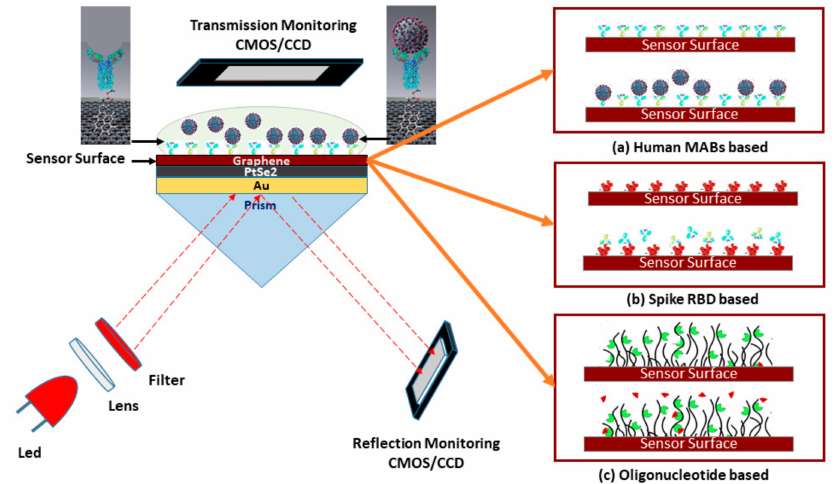
Figure 2. Schematic diagram of the five-layered (Bk 7 /Au/PtSe 2 /Graphene/PBS) SPR biosensor for diagnosis of SARS-CoV-2 cultured virus; three operating modes are represented to detect the SARS-CoV-2 virus: ( a ) rapid recognition of whole virus spike RBD with immobilized human mAbs (mAbs as ligand and spike RBD as analyte), ( b ) rapid recognition of mAbs with immobilized virus spike RBD (spike RBD as ligand and mAbs as analyte), and ( c ) or recognition of the virus RNA sequence with immobilized probe sequence onto the graphene implicated sensor